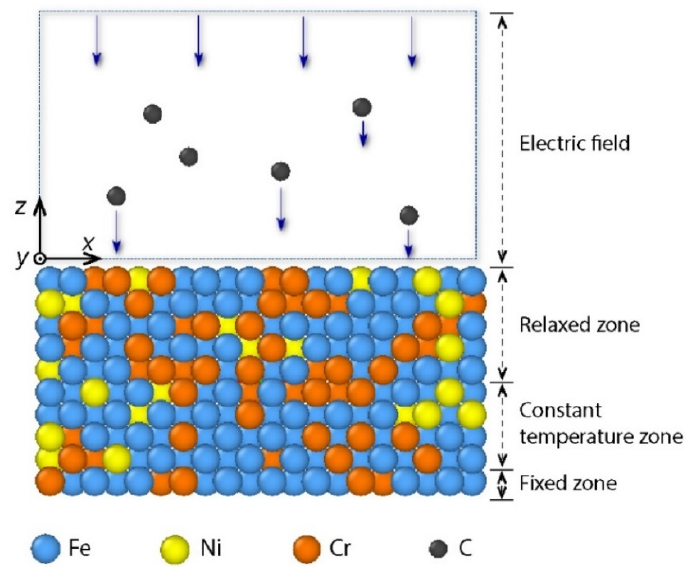
Figure 1. Schematic illustration of carbon film growth on AISI 316L substrate.